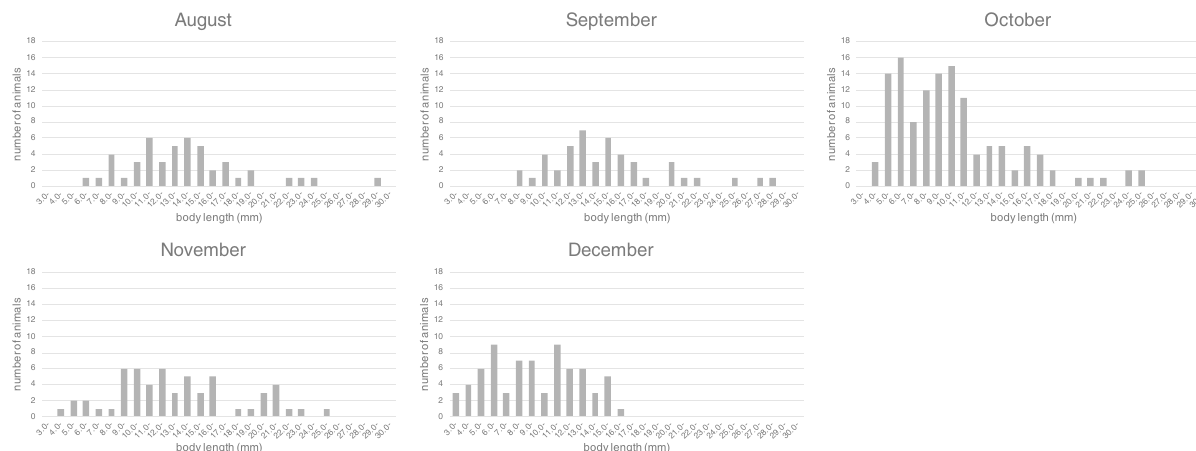
Fig. 2 Size distribution of Xenoturbella bocki collected from August to December within Gullmarsfjord from 2005 to 2006. August n = 47, September n = 46, October n = 127, November n = 57, December n = 72.